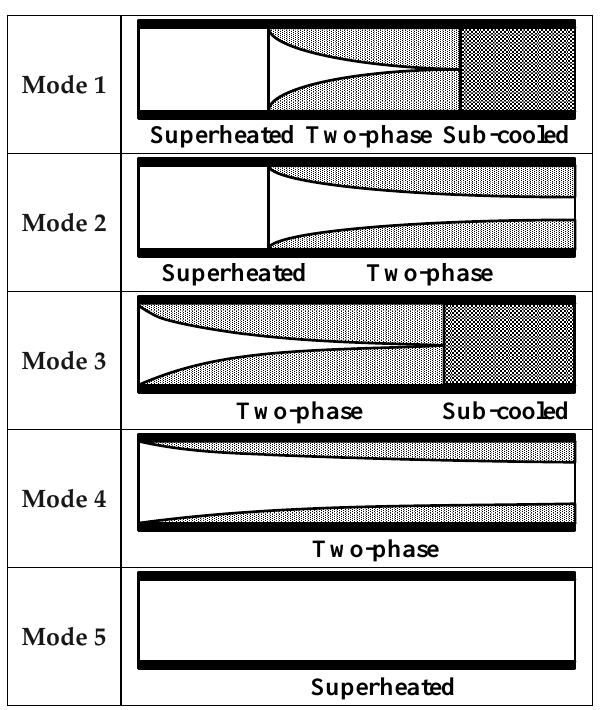
Figure 3. Modes of the condenser.